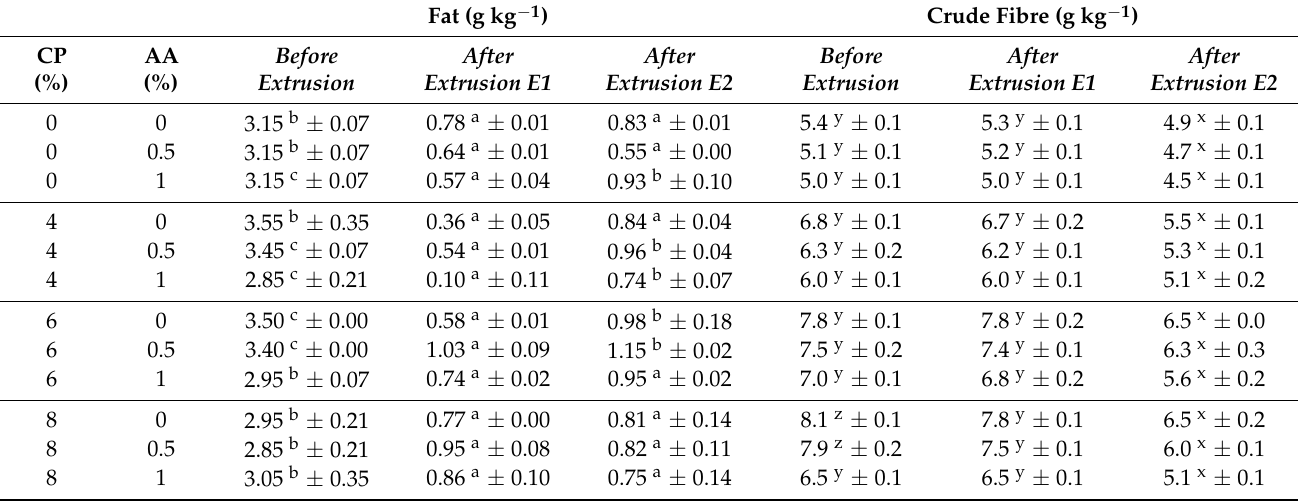
Table 2. Fat and crude fiber content in raw and extruded samples A, B